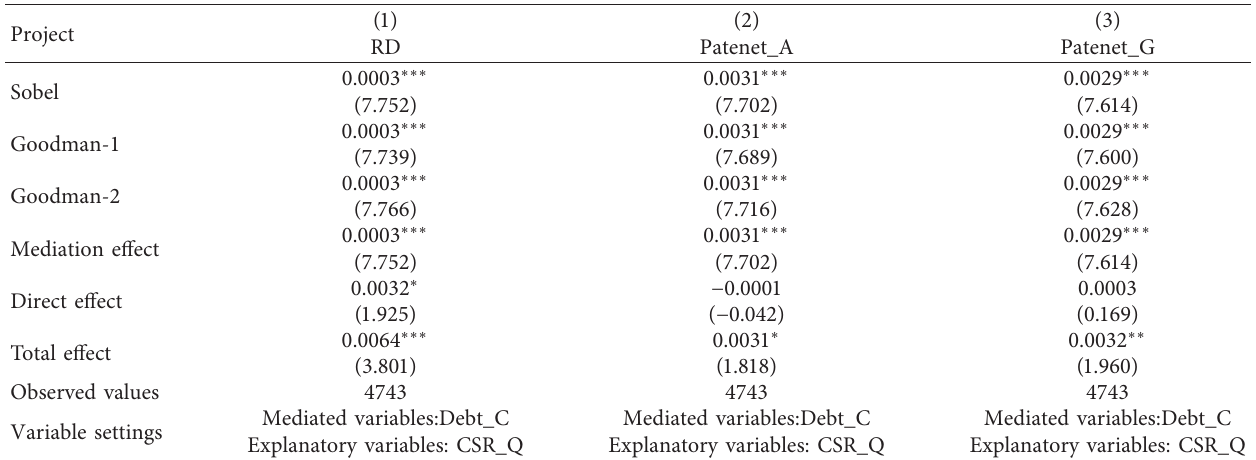
Table 13: Sobel–Goodman test for mediating effects.